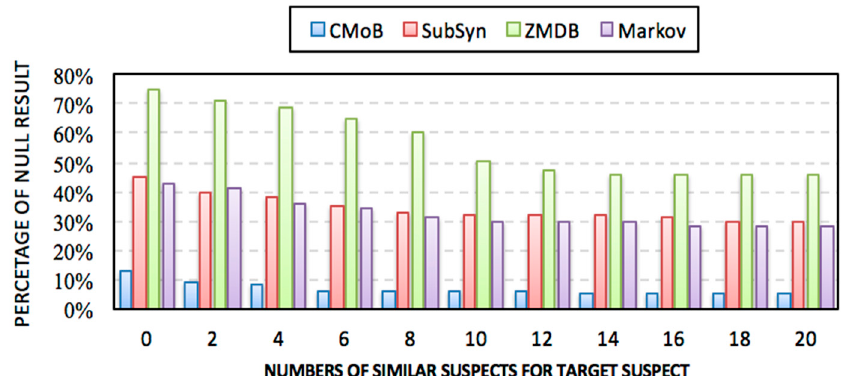
Figure 13. Missing Percentiles.